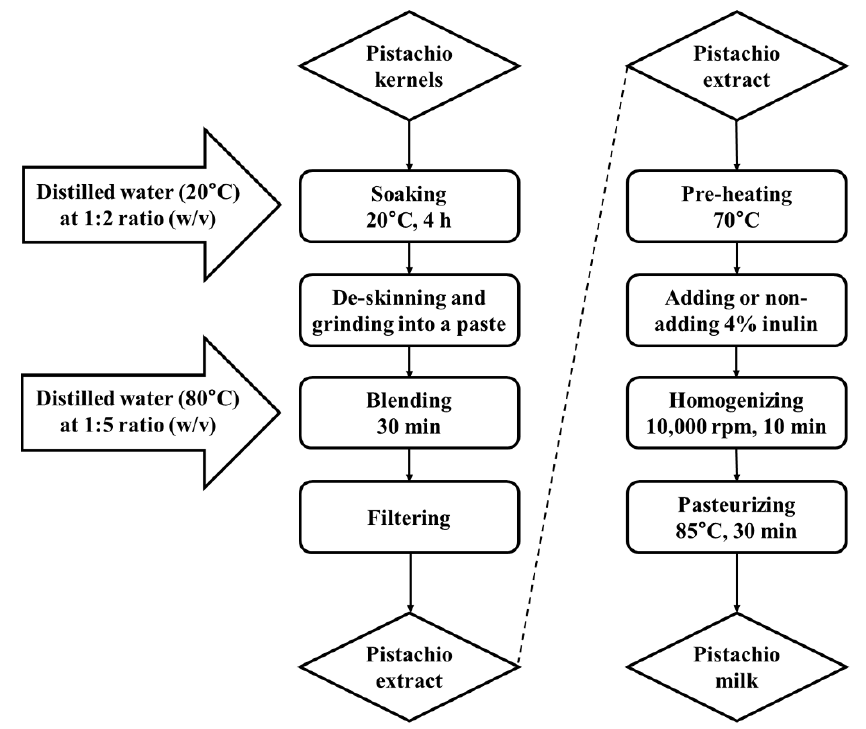
Figure 1. The process for the production of pistachio milk (PM).